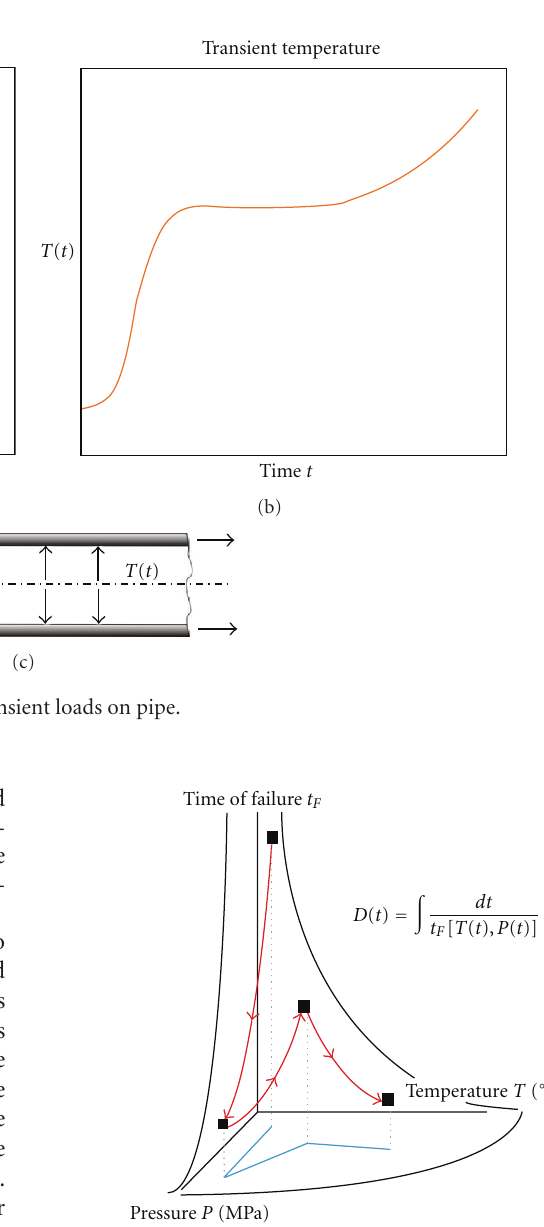
Figure 2: Linear damage accumulation hypothesis in